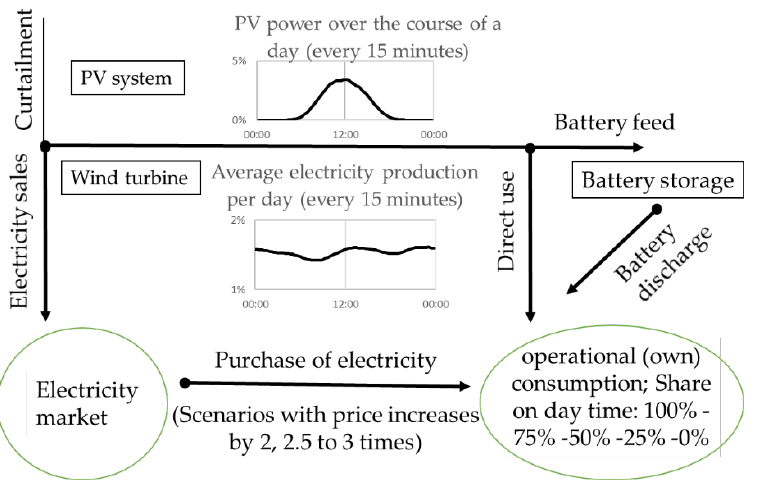
Figure 2. Model with components of electricity generation and storage, representation of electricity market (with price increase) and the farm’s own consumption with variable day/night consumption shares.